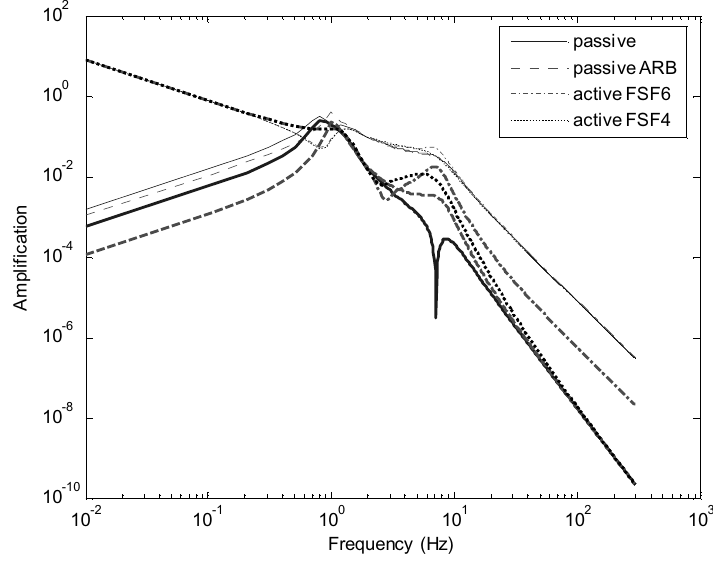
Fig. 15. Suspension deflection for right road